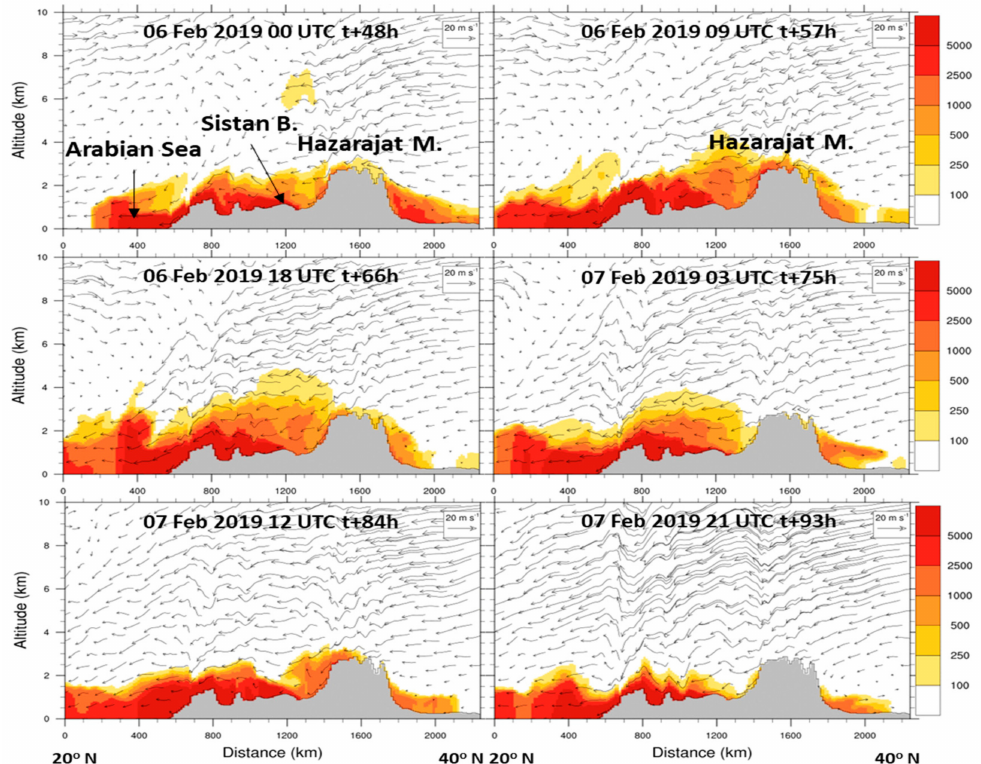
Figure 10. Vertical cross sections of dust concentration (in µ g m − 3 ) from 20 ◦ N to 40 ◦ N along 65 ◦ E (red line in Figure 8) for certain hours during 5–7 February 2019 (LST = UTC + 5.30). The winds along the cross sections are superimposed in vectors. The distance in km starts from 20 ◦